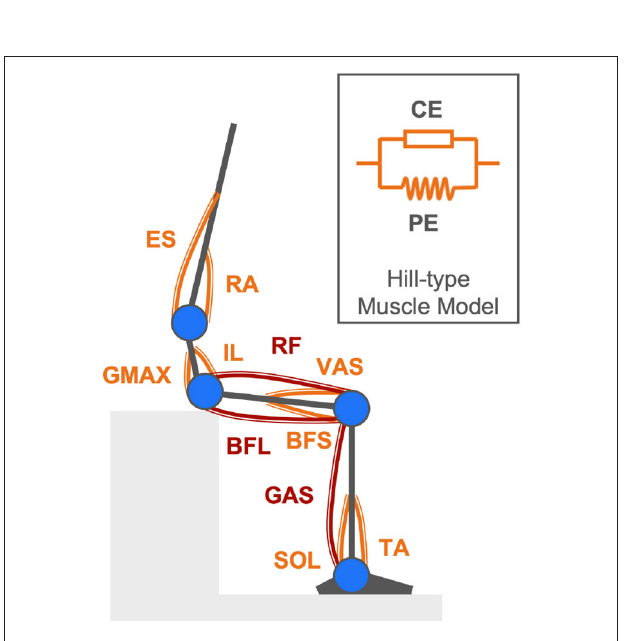
FIGURE 2 | Musculoskeletal model comprising eight uniarticular muscles (orange components) and three bi-articular muscles (maroon components) described by the Hill-type muscle model for rendering the human body STS movement in forward dynamics